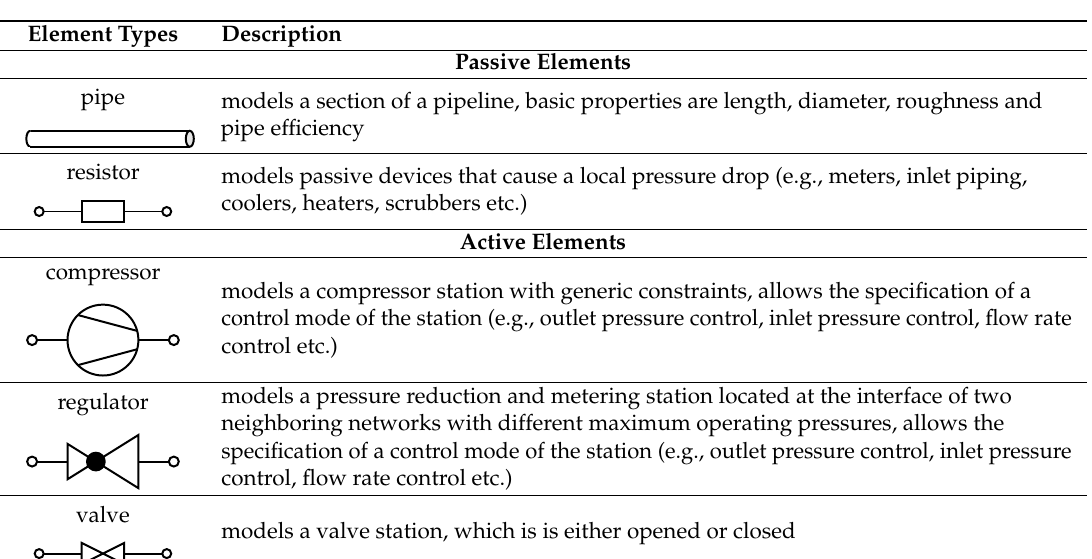
Table 1. Basic elements comprising gas transport networks.